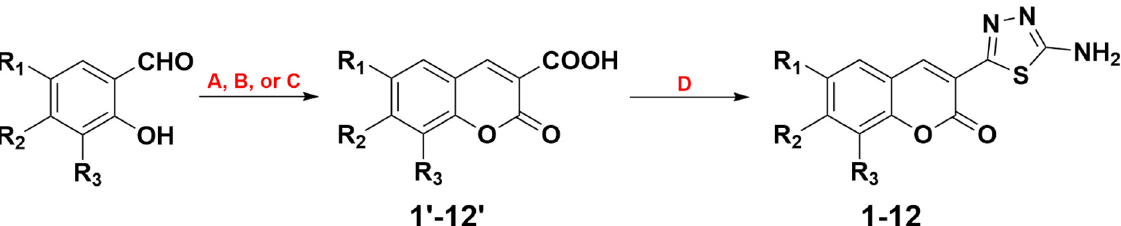
Figure 2. Synthetic pathway for the synthesis of coumarin–thiadiazole hybrids 1-12 : ( A ) diethyl malonate, piperidine, 40 °C; ( B ) Meldrum’s acid, piperidine, acetic acid, ethanol, reflux; ( C ) Meldrum’s acid, H 2 O, reflux; ( D ) POCl 3 , thiosemicarbazide, 75 °C.